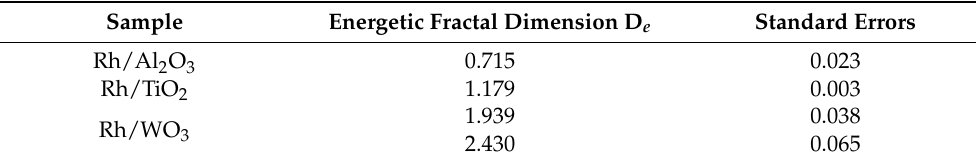
Table 2. The energetic fractal dimension D e computed from Equation (17) and considering TEM fractal dimension as a geometric fractal dimension (see Table